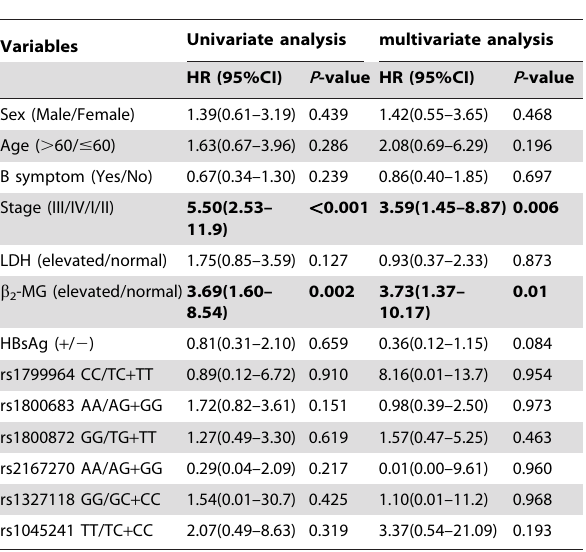
Table 3. Univariate and multivariate analysis for PFS in NK/T- cell lymphoma